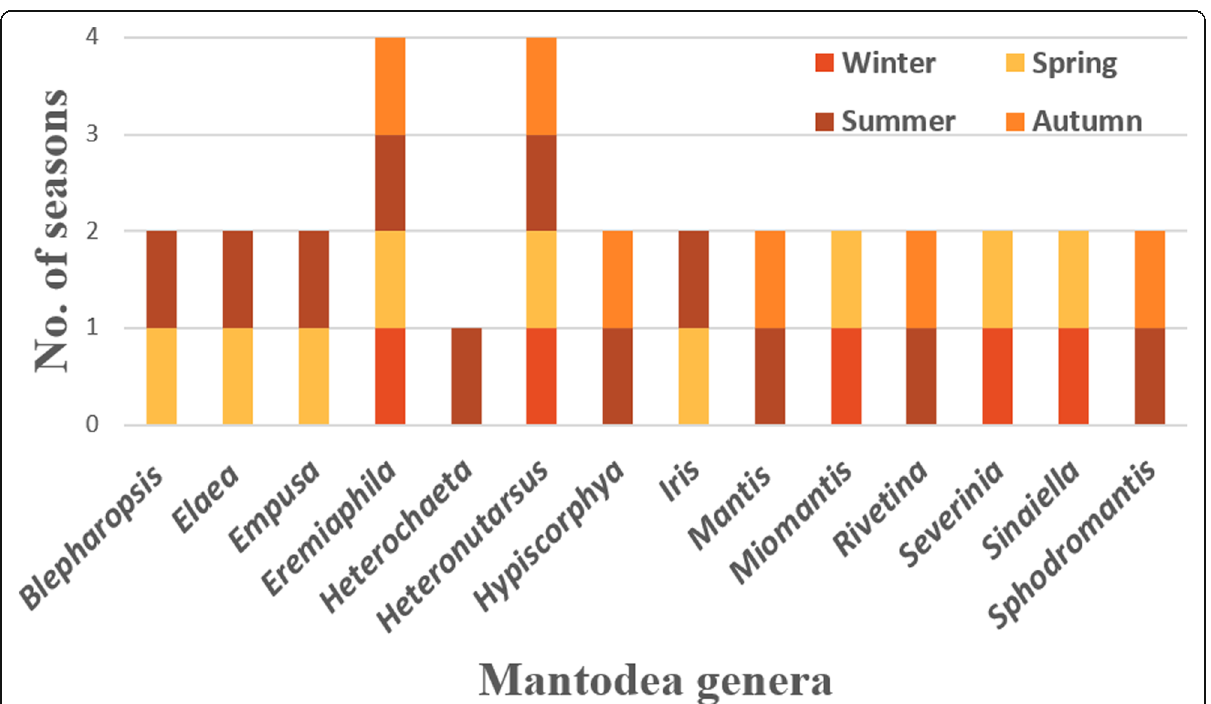
Fig. 5 Histogram illustrating the seasonality appearance of the adult stage of most common genera of Mantodea in